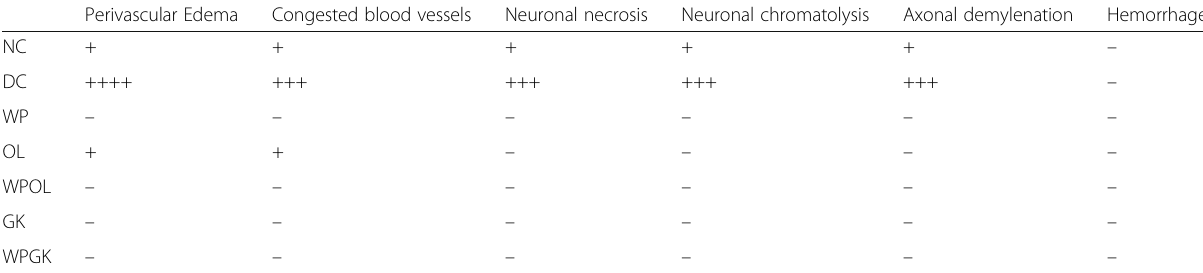
Table 5 Effect of administration of whey protein mixed with Garcinia kola and olive leaves on histological picture of brain in diabetic rats Perivascular